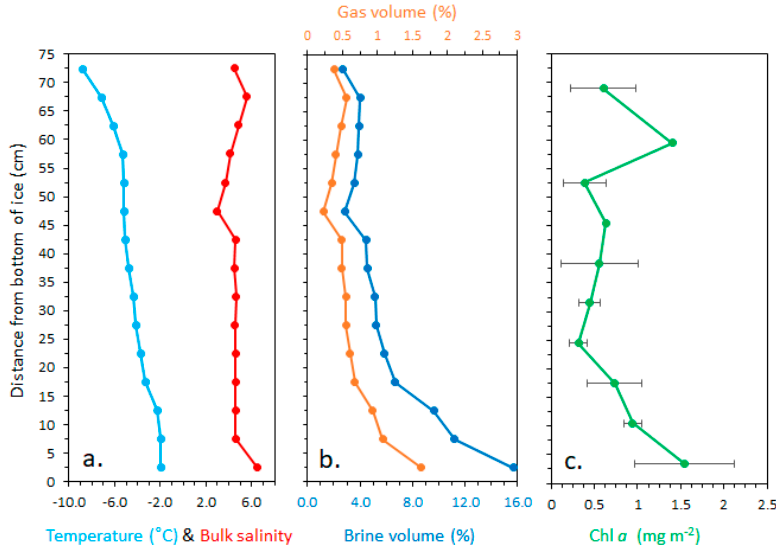
Figure 2. Ice temperature and bulk salinity and ( a ), brine and gas volumes ( b ), and chlorophyll a ( c ). Below ice water temperatures varied between − 1 °C and − 0.5 °C and salinity between 21.7 and 23, with peaks in salinity likely related to double diffusion [29], but there was no stratification of the water column (Figure 3a). Similarly for the optical constituents Chl a and SPM, there were likewise no variations with depth, with a Chl a of about 0.65 µ g L − 1 in the entire water column and SPM concentrations between 1.2 and 1.5 mg L − 1 (Figure 3b).